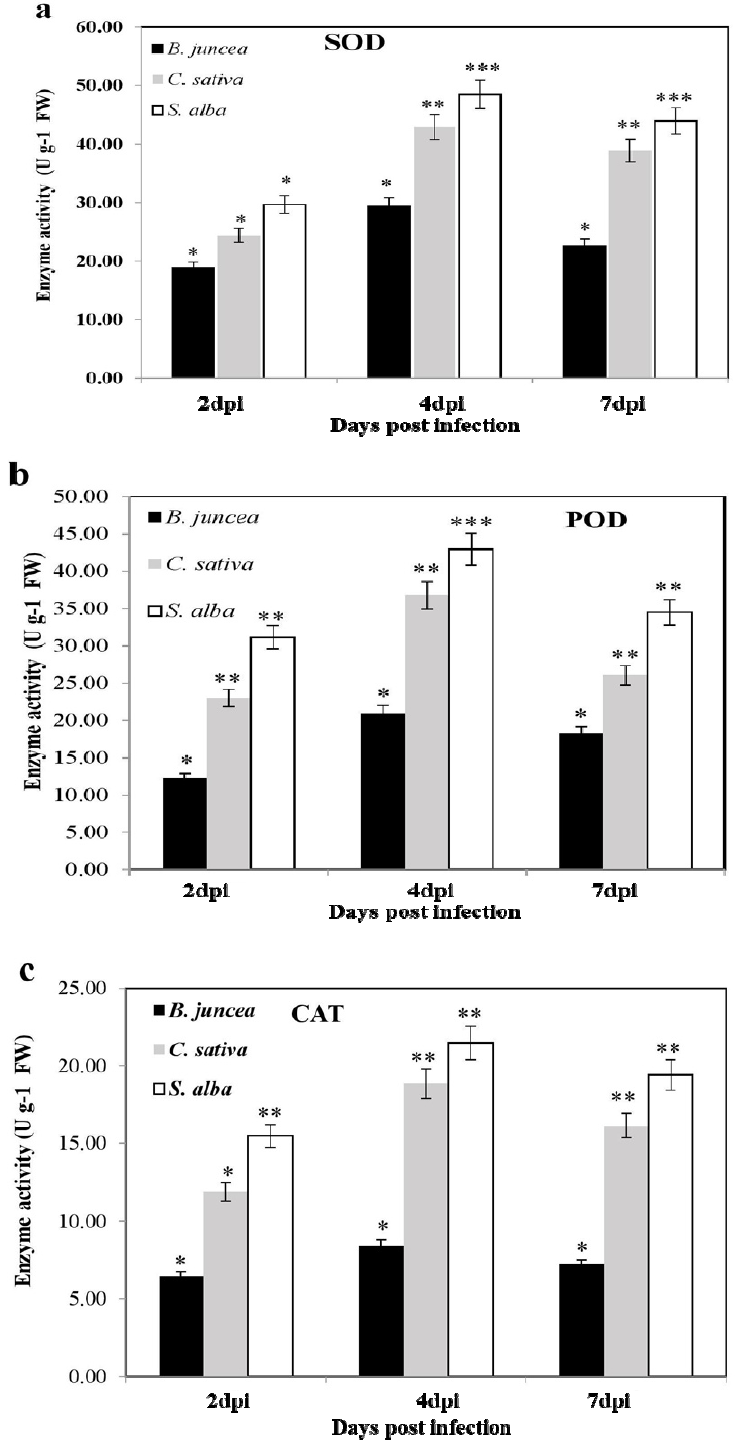
Figure 3. Antioxidant enzyme profiling in B. juncea , C. Sativa , and S. alba after powdery mildew infection. ( a ) SOD activity in B. juncea , C. Sativa , and S. alba after powdery mildew infection. ( b ) POD activity in B. juncea , C. Sativa , and S. alba after powdery mildew infection. ( c ) CAT activity in B. juncea , C. Sativa , and S. alba after powdery mildew infection. Asterisks shows statistically significant (* p < 0.05) or extremely significant (** p < 0.01) or (*** p <